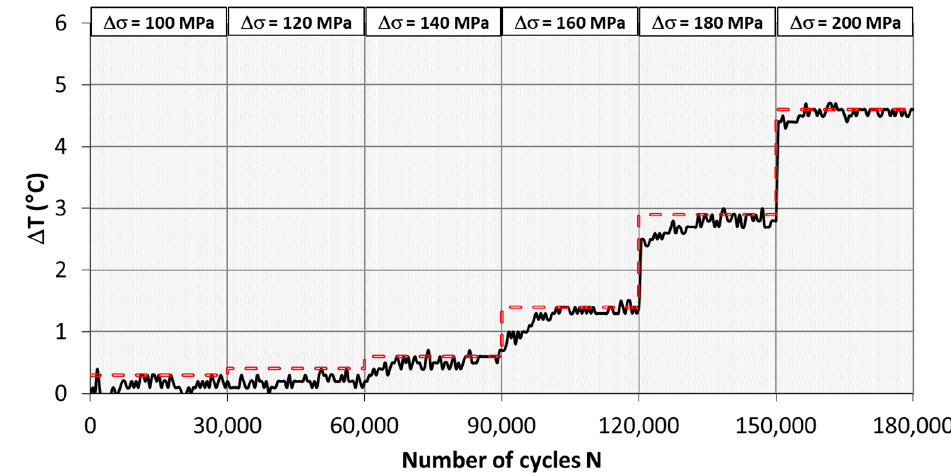
∆ T-N curve obtained by stepwise load (991-FM-2 specimen, Figure 5. Δ T-N curve obtained by stepwise load (991-FM-2 specimen, type-NC-4). Figure 5.